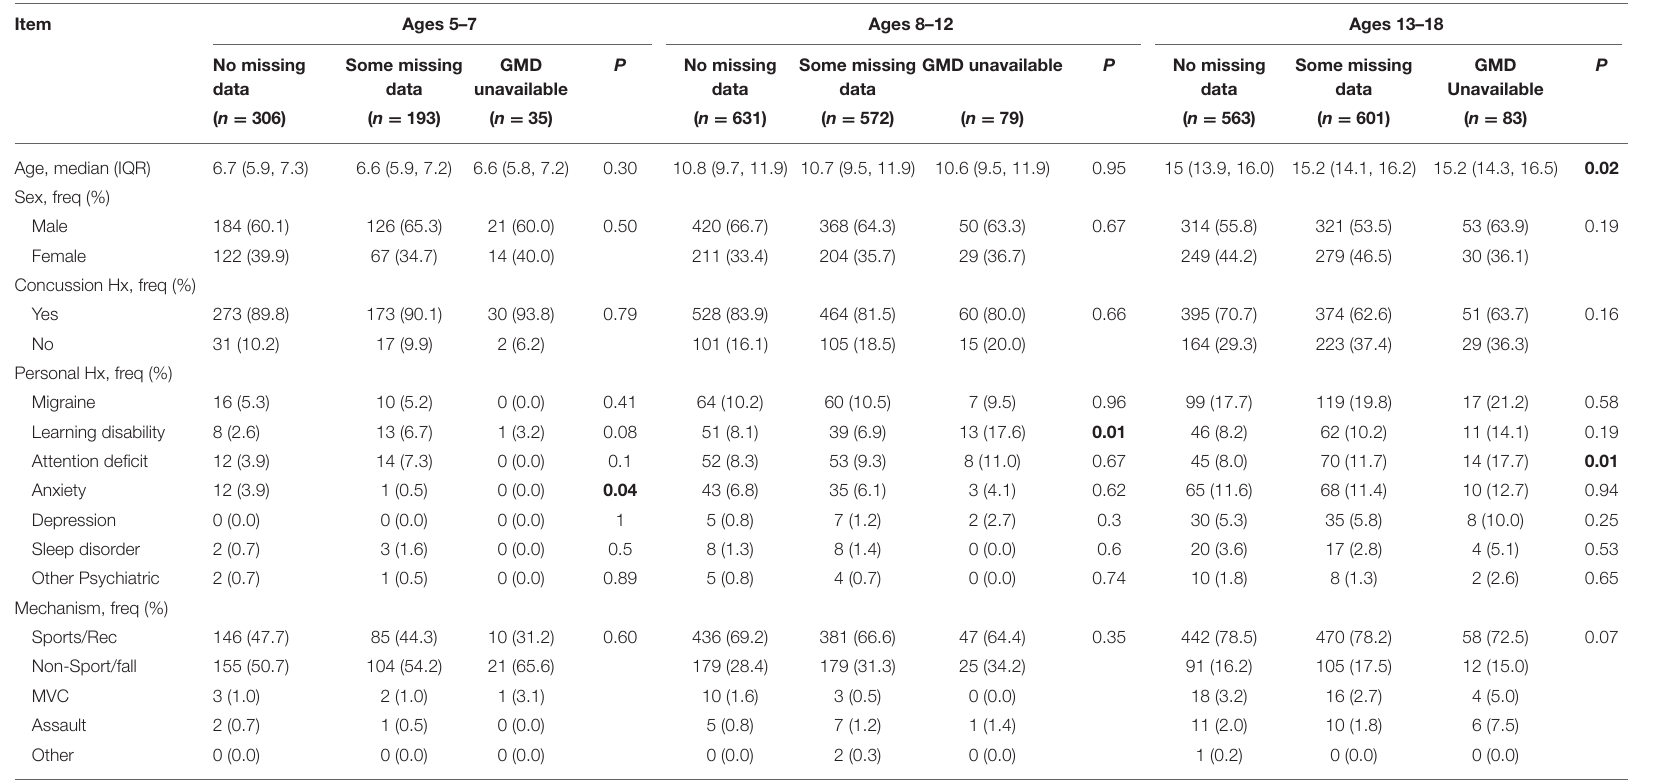
TABLE 2 | Descriptive statistics for the 5–7, 8–12, and 13–18-year-old age